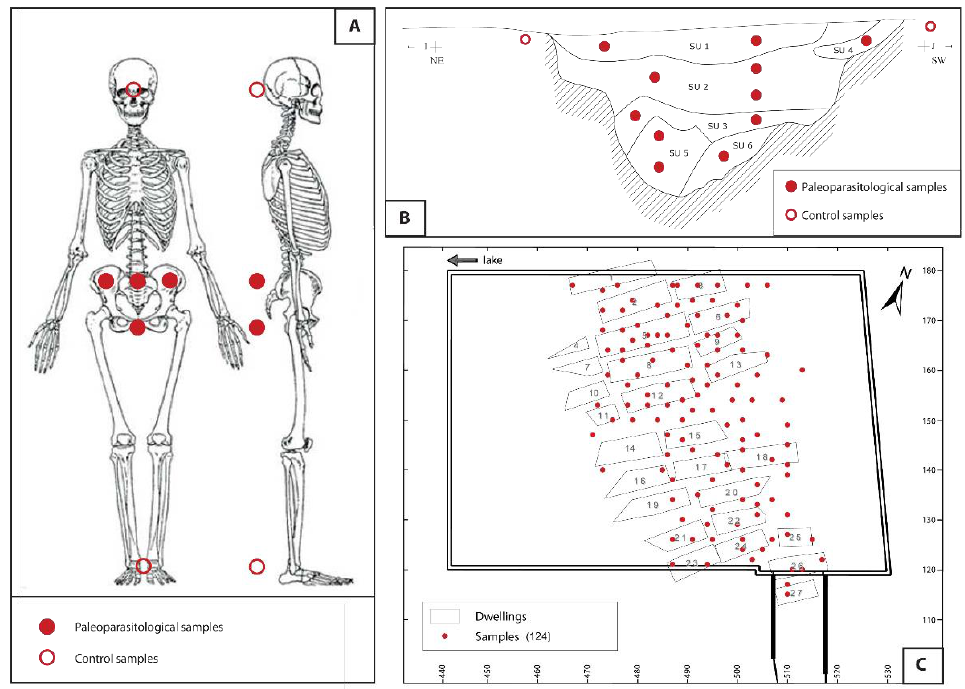
Figure 1. Various sampling strategies depending on various archaeological context: ( A ) sampling on skeletons; ( B ) sampling in hollowed structures as latrines or pits; ( C ) sampling in occupation layers (example of Zurich Parkhaus Opera, Switzerland).